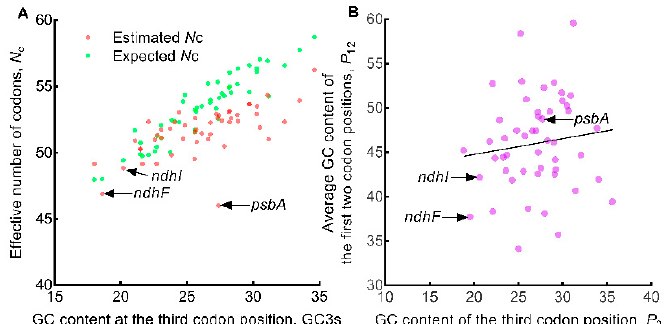
Figure 6. Exploring the influencing factors of codon usage in oak chloroplast genome. The solid color circles represent the 50 genes. ( A ) Estimated N c (effective number of codons) versus expected N c plot analysis. ( B ) P 12 versus P 3 plot analysis. The solid line represents the regression of P 12 (average of P 1 and P 2 ) against P 3 , equation y = 0.1791 x + 41.17, R 2 = 0.0155, p = 0.389. Table 3. Test of independence between different codon positions in the 4-fold degenerate families. Amino acids